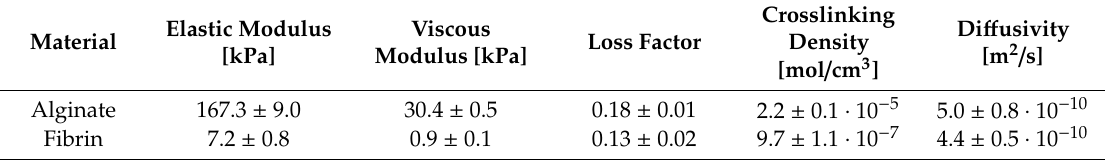
Table 1. Hydrogels chemical-physical characteristics. Data are reported as mean ± s.d.